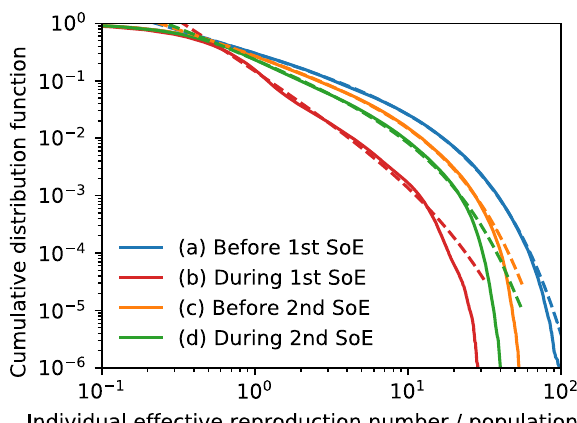
Figure 8. Cumulative distribution function of individual effective reproduction number on a log–log scale ( a ) 2 months before 1st SoE, ( b ) during 1st SoE, ( c ) 2 months before 2nd SoE, and ( d ) during 2nd SoE. Fitting functions are plotted as dotted lines: ( a ) 0.33 r − 0.76 exp ( − 0.078 r ) , ( b ) 0.16 r − 1.72 exp ( − 0.080 r ) , ( c ) 0.30 r − 0.86 exp ( − 0.105 r ) , and ( d ) 0.26 r − 1.03 exp ( − 0.108 r ) , where R distribution is the effective reproduction